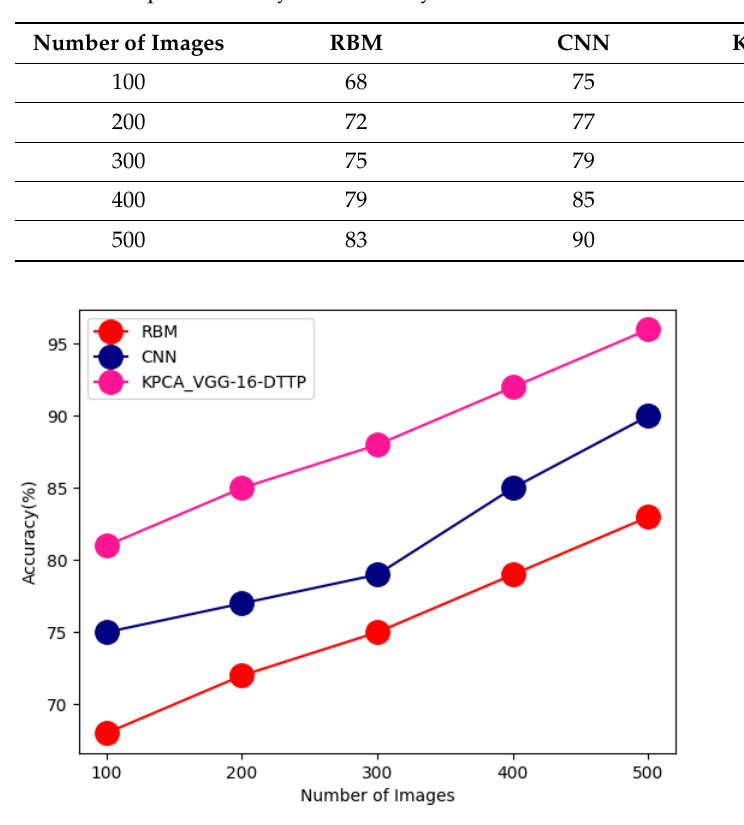
Figure 2. Comparison of Accuracy.